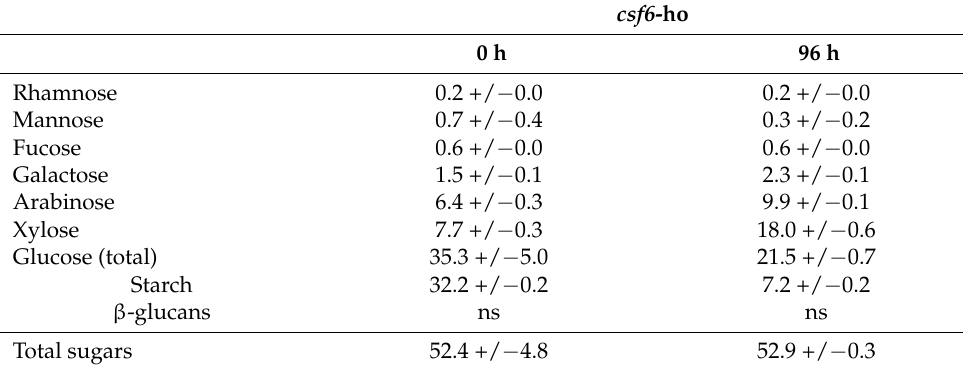
Table 3. Sugar composition of the alcohol-insoluble residues (AIR) of imbibed and germinated (96 h of germination) grains of the homozygous cslf6 mutant determined by gas chromatography analysis. Determination of starch and MLG contents by HPAEC analysis. The results are expressed as a percentage of AIR dry matter. cslf6 -ho: homozygous cslf6 mutant. csf6 -ho 0 h 96 h Rhamnose 0.2 +/ − 0.0 0.2 +/ − 0.0 Mannose 0.7 +/ − 0.4 0.3 +/ − 0.2 Fucose 0.6 +/ − 0.0 0.6 +/ − 0.0 Galactose 1.5 +/ − 0.1 2.3 +/ − 0.1 Arabinose 6.4 +/ − 0.3 9.9 +/ − 0.1 Xylose 7.7 +/ − 0.3 18.0 +/ − 0.6 Glucose (total) 35.3 +/ − 5.0 21.5 +/ − 0.7 Starch 32.2 +/ − 0.2 7.2 +/ − 0.2 β -glucans ns ns Total sugars 52.4 +/ − 4.8 52.9 +/ −